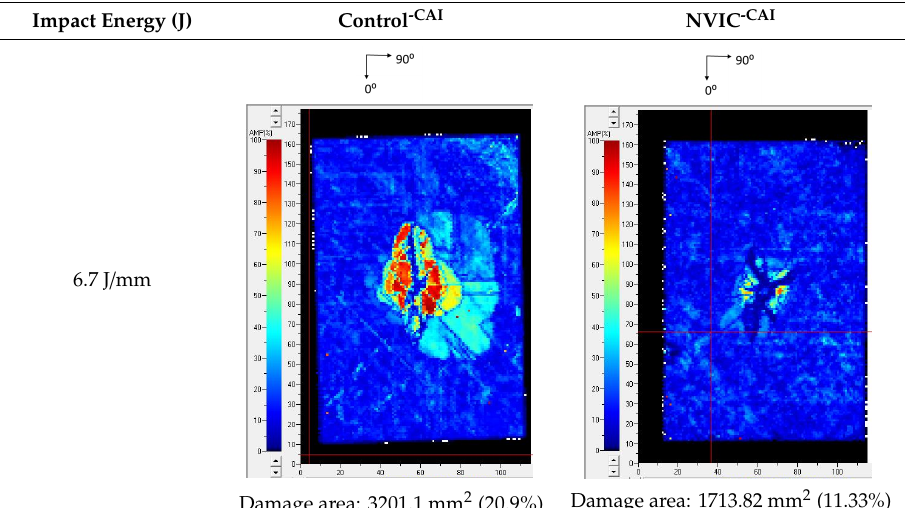
Table 7. Characteristics of impact damage area.